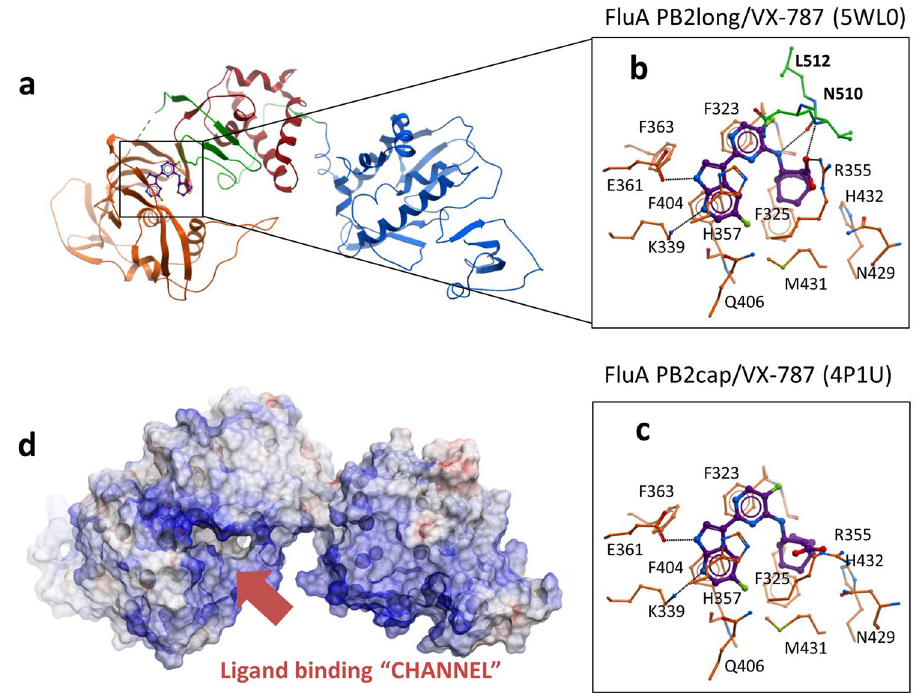
Figure 2. Structural characterization of FluA PB2long. ( a ) Crystal structure of PB2long/VX-787 and detailed interactions of VX-787 with PB2long ( b ) or PB2cap ( c , pdb accession 4P1U). ( d ) Electrostatic surface of PB2long with bound VX-787.